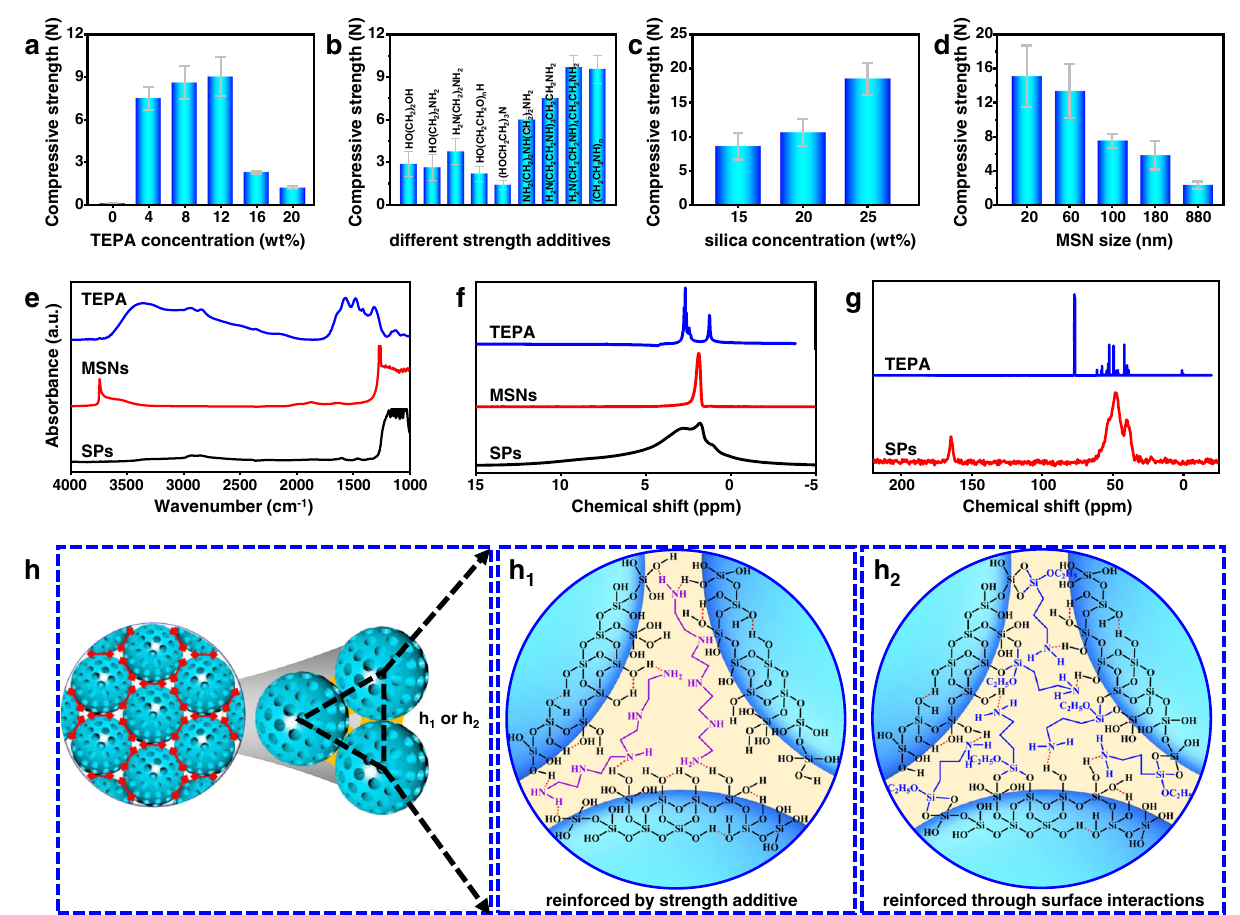
Fig. 3 | Key factors impacting of the mechanical strength of SPs. a Mechanical strength of SPs prepared with different concentrations of TEPA. b Mechanical strength for SPs prepared with different strength additives. c Mechanical strength of SPs prepared with different concentrations of MSNs. d Mechanical strength for SPspreparedwithdifferentsizedMSNs.Errorbarsindicatethestandarderrorfrom